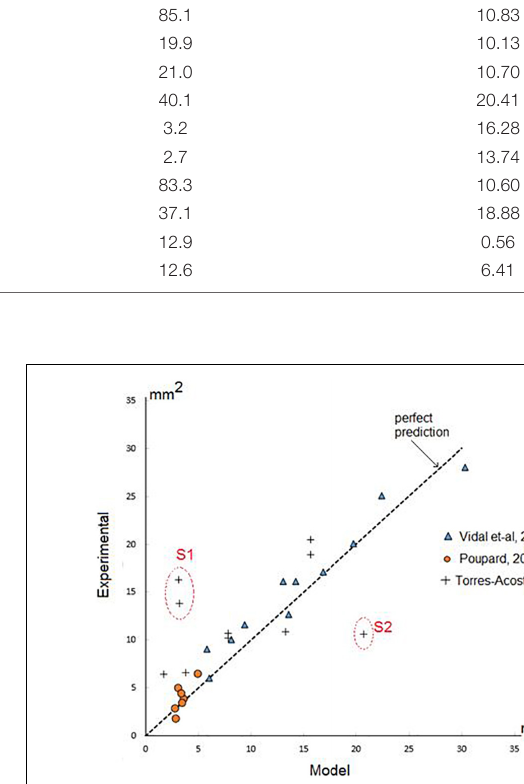
FIGURE 6 | Experimental vs. FEM data plot of the three beams studied, showing a high